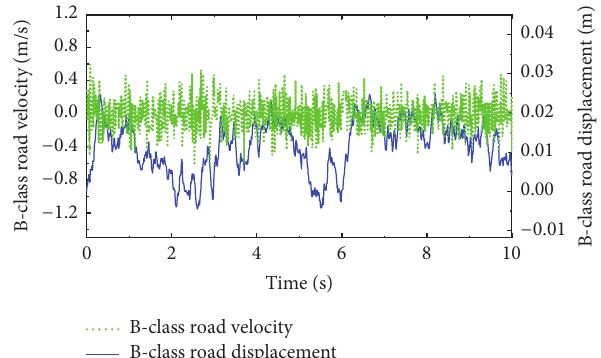
Figure 2: The road excitation used for simulation. the tire road holding. Therefore, the state variable X and the output vector Y are selected as follows: X = Y